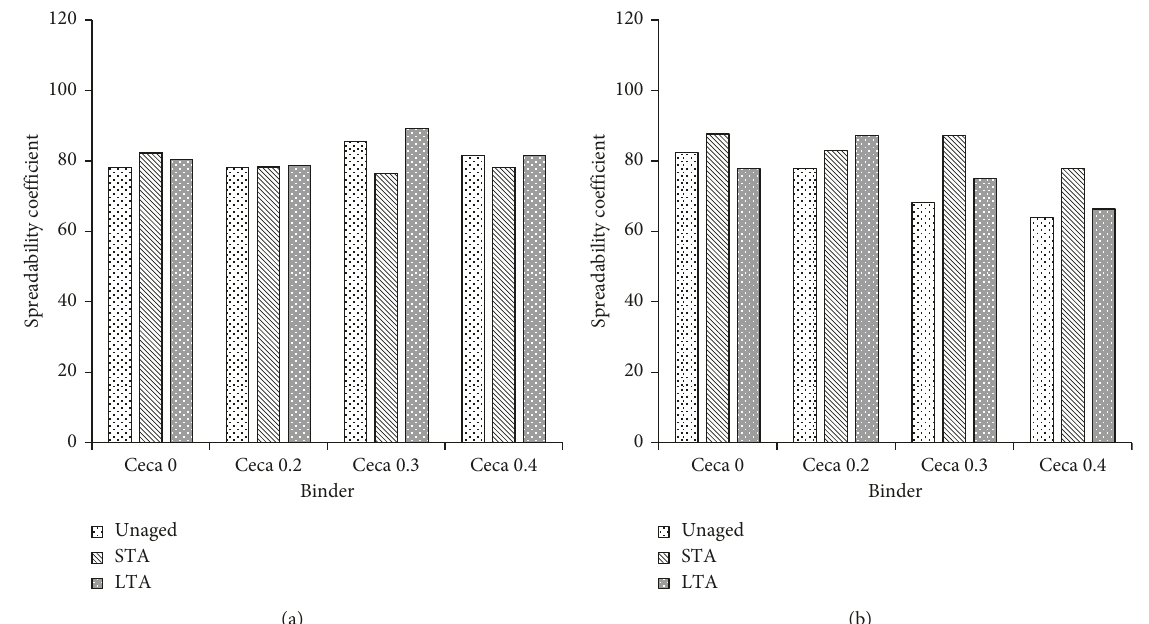
Figure 11: Spreadability coefficient of PG-76 asphalt binder: (a) limestone; (b)